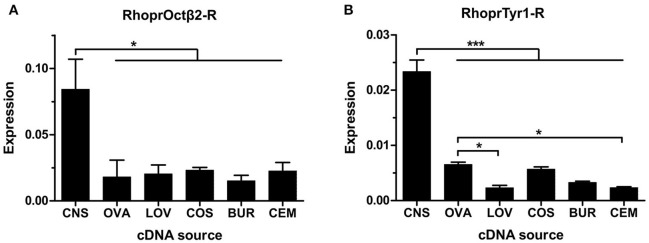
Spatial analysis of transcript expression of biogenic amine receptors in the adult female reproductive system. (A) RhoprOctβ2-R transcript is widely distributed in the reproductive tissues. The expression of RhoprOctβ2-R is significantly higher than the reproductive tissues (one-way ANOVA followed by Tukey multiple comparisons test; *P < 0.05). (B) RhoprTyr1-R transcript is expressed in all reproductive tissues. RhoprTyr1-R transcript expression in the ovary is significantly higher than the lateral oviducts and the cement gland (one-way ANOVA followed by Tukey multiple comparisons test; *P < 0.05, ***P < 0.001). CNS, central nervous system; OVA, ovary; LOV, lateral oviduct; COS, common oviduct and spermatheca; BUR, bursa; CEM, cement gland. Data represents the mean ± SEM of three biological replicates for RhoprOctβ2-R and four biological replicates for RhoprTyr1-R, each biological replicate included two technical replicates.